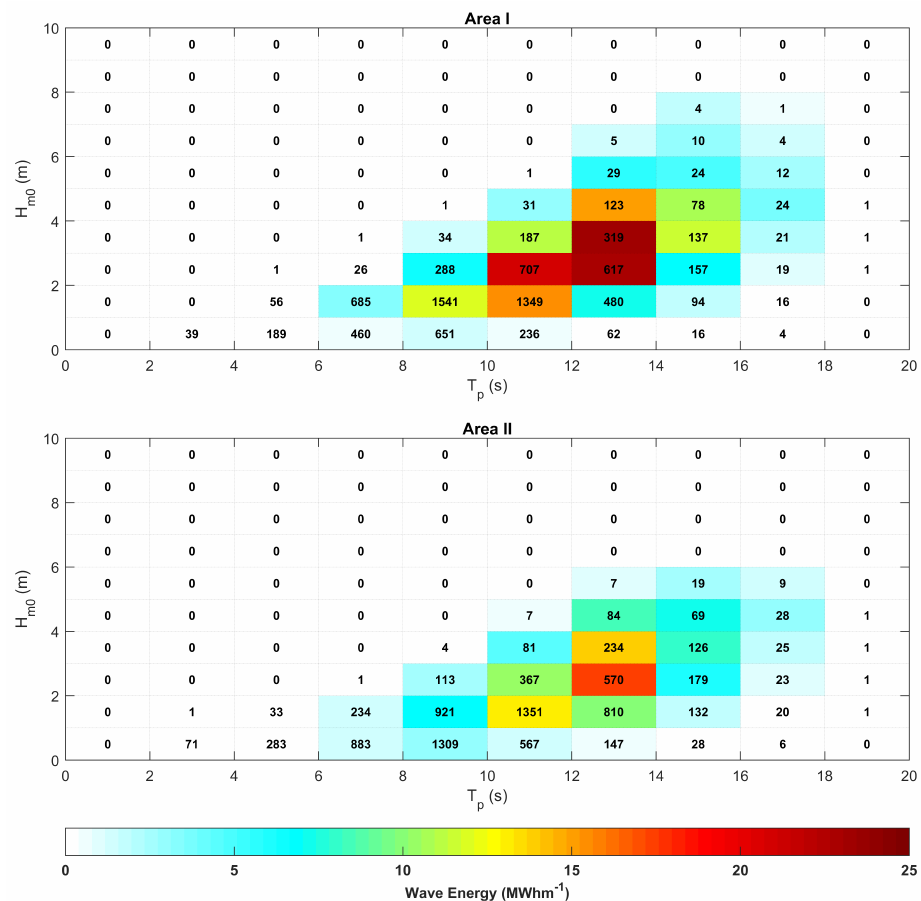
Figure 8. Wave energy resource matrices for the potential wave energy sites (Colourmap represents the annual energy per meter of wave front and the numbers represent the occurrence in annual hours for each sea state ( O i )).